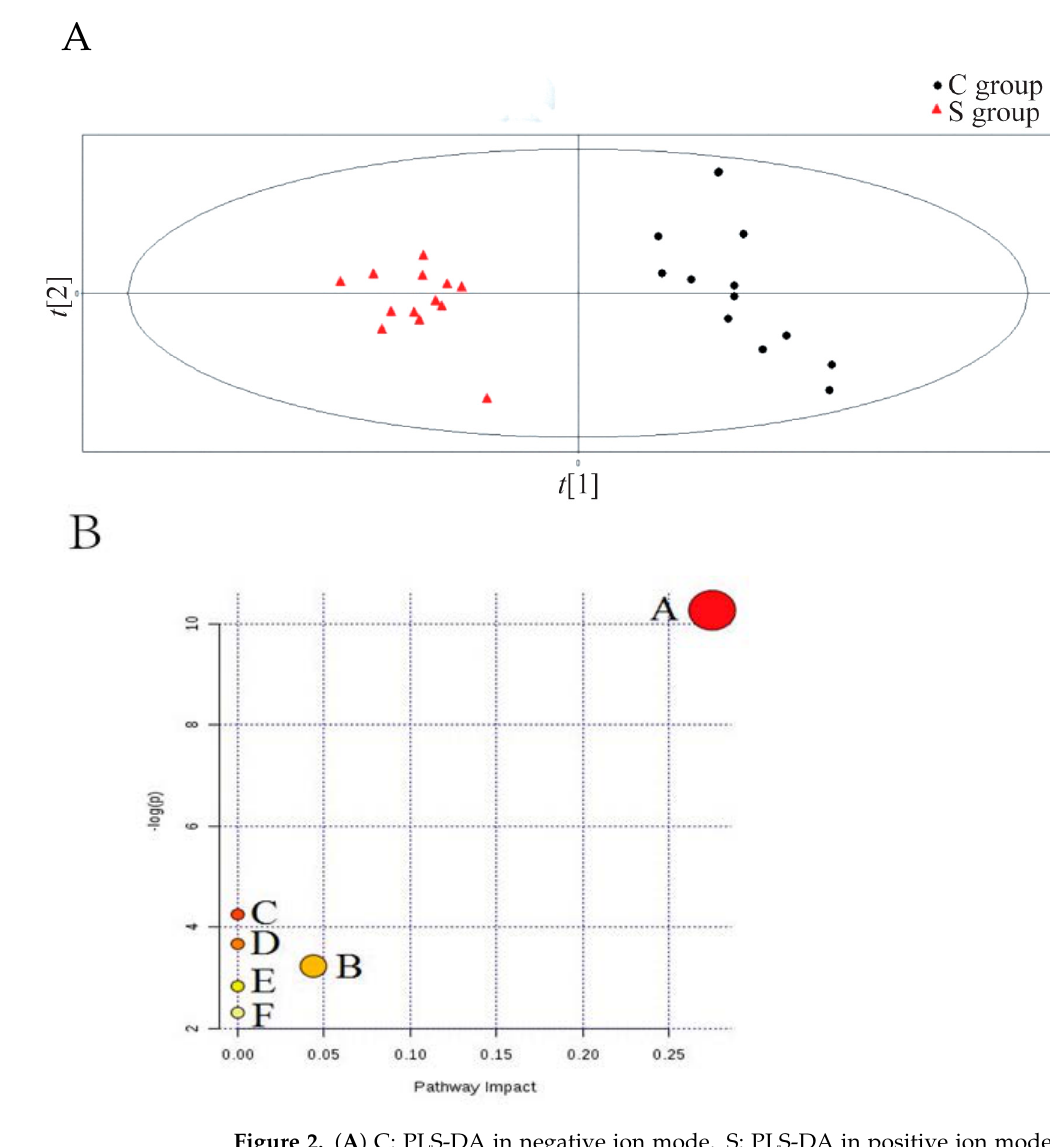
Figure 2. ( A ) C: PLS-DA in negative ion mode. S: PLS-DA in positive ion mode. In the C and S panels, the black boxes (.) represent samples from the C group; the open triangles ( ∆ ) represent samples from the S group. ( B ) Pathway analysis of the biomarkers of the sevoflurane-induced neurogenerative disease model. All matched pathways were acquired according to the p